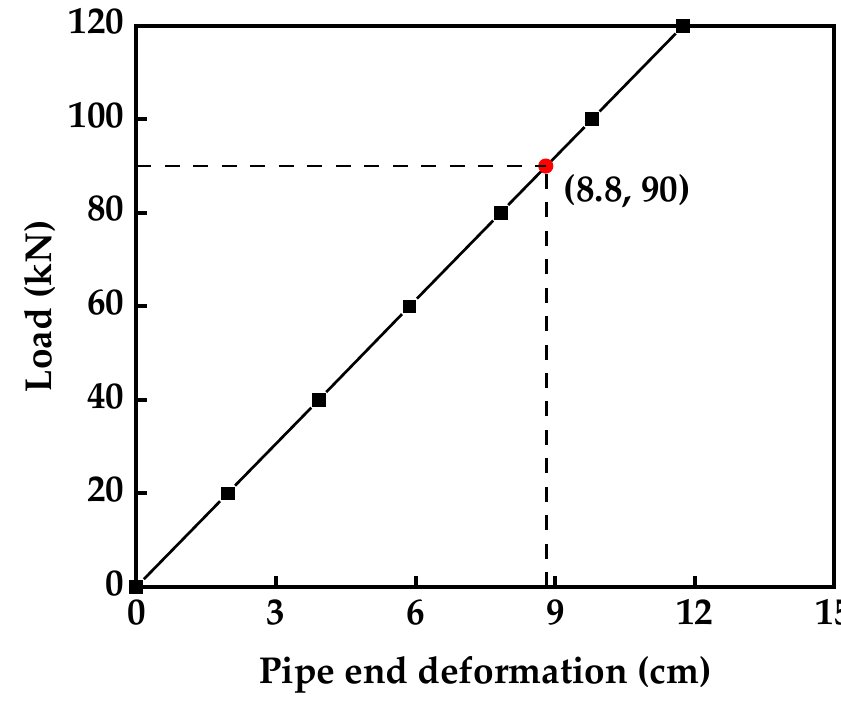
Figure 3. Load – pipe-end deformation